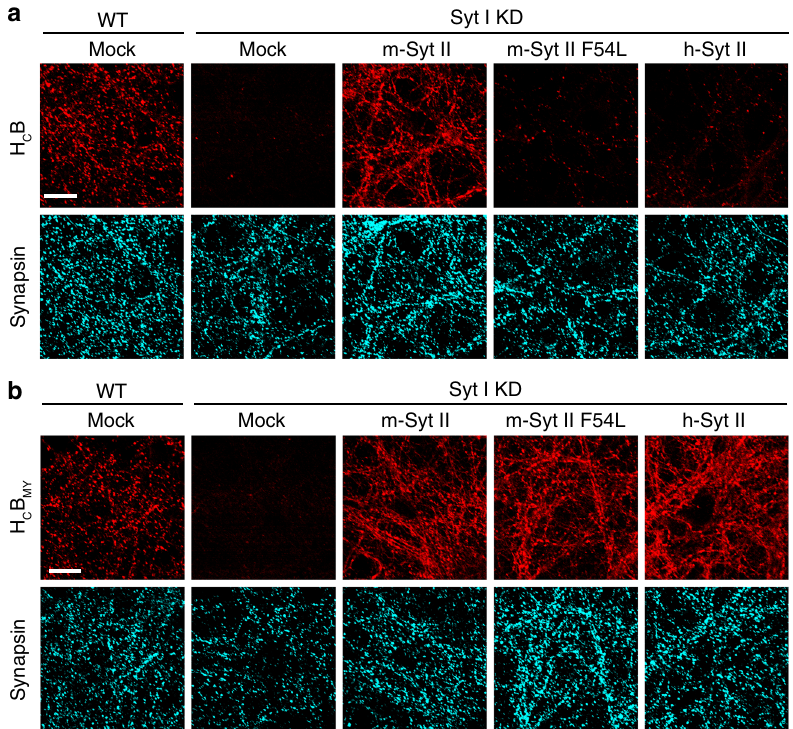
Fig. 3 H C B MY shows robust binding to neurons that express h-Syt II. a Humanized neurons were created by KD of endogenous Syt I and by expressing full-length h-Syt II in cultured rat cortical neurons via lentiviral transduction. KD ef fi ciency was validated by immunoblot (Supplementary Fig. 5). Neurons that express full-length m-Syt II or m-Syt II (F54L) served as controls. These neurons were exposed to WT H C B (100 nM) followed by immunostaining analysis. Bound H C B was detected via an HA-tag fused to H C B. Synapsin was labeled as a marker for presynaptic terminals. WT H C B bound to WT neurons but not to Syt I KD neurons. Expression of full-length m-Syt II restored binding of H C B. Expression of full-length m-Syt II (F54L) or full-length h-Syt II resulted in only low levels of binding of WT H C B compared to m-Syt II. b Syt I KD abolished binding of H C B MY (100 nM) to neurons. The binding was rescued by expression of full-length m-Syt II, m-Syt II (F54L), or h-Syt II. Scale bars represent 20 µ m. One of two independent experiments is